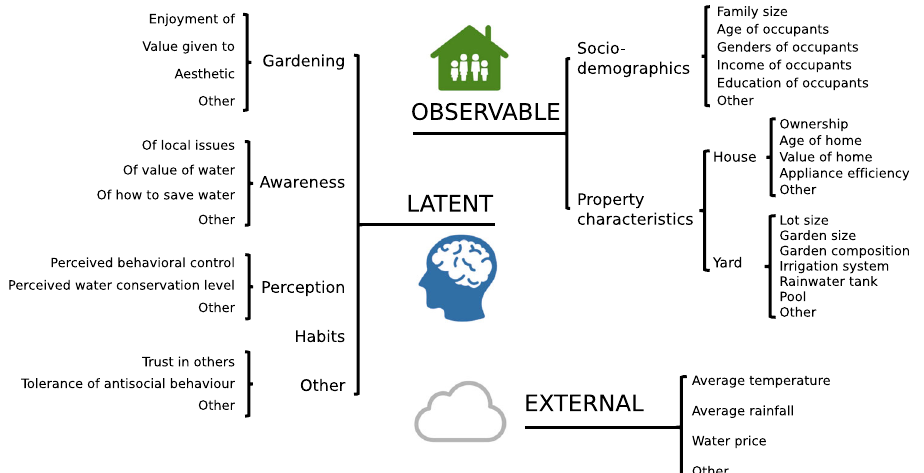
Fig. 2 Household water consumption determinant classi fi cation system. Potential water use determinants are classi fi ed in three categories, namely observable, latent, and external. Observable determinants are de fi ned as those determinants that can be physically seen or measured. Latent determinants relate to the way the occupants of the household think, feel, or act. External determinants are external to the house and might in fl uence a suburb or groups of houses at a regional